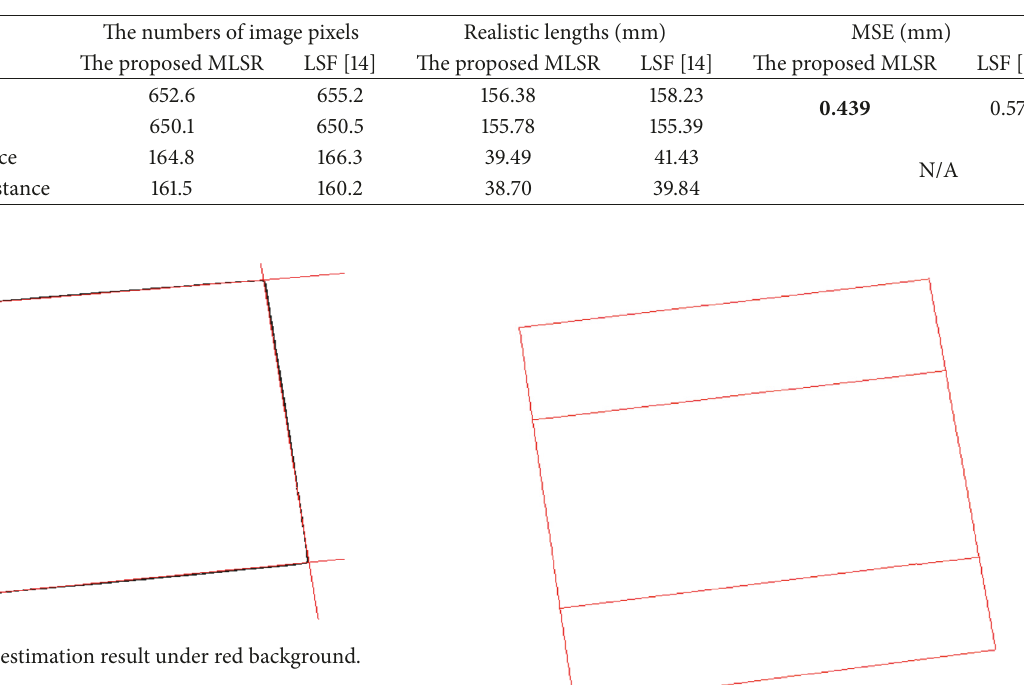
Table 5: Length comparisons of estimated edges.